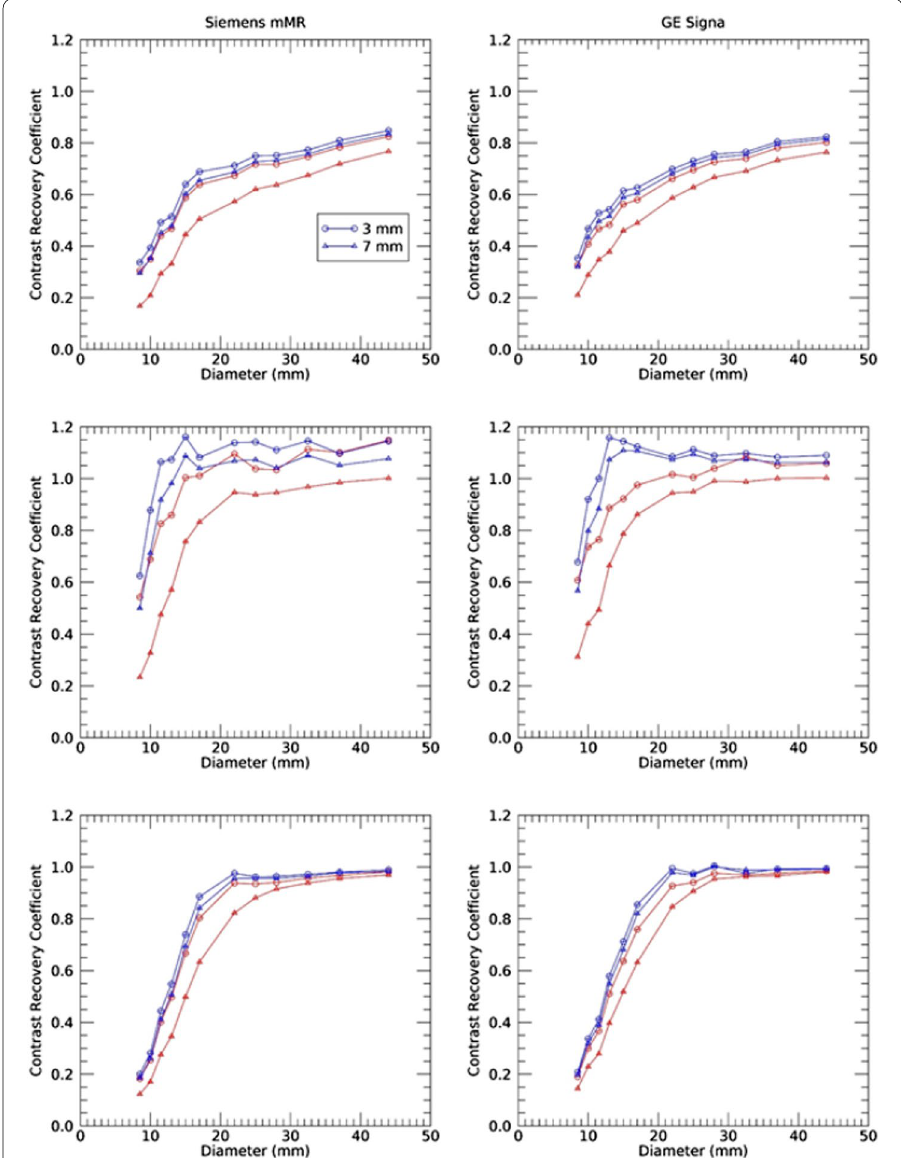
Fig. 2 Contrast recovery coefficient (CRC) curves for mean (top), maximum (middle) and peak (bottom), without resolution recovery, either PSF or IR (red), and with resolution recovery (blue) for the GE Signa (right) and Siemens mMR (left) scanners. CRC curves are presented for two post-reconstruction filter widths. Only the least filtration (3 mm) and highest filtration (7 mm) are